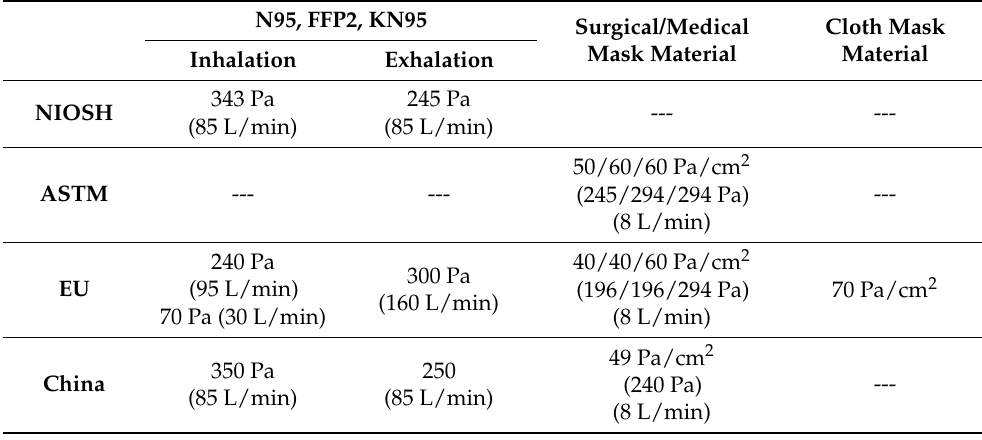
Table 2. Maximum allowed pressure drop for PPEs and surgical/medical masks per different standards around the globe [37].